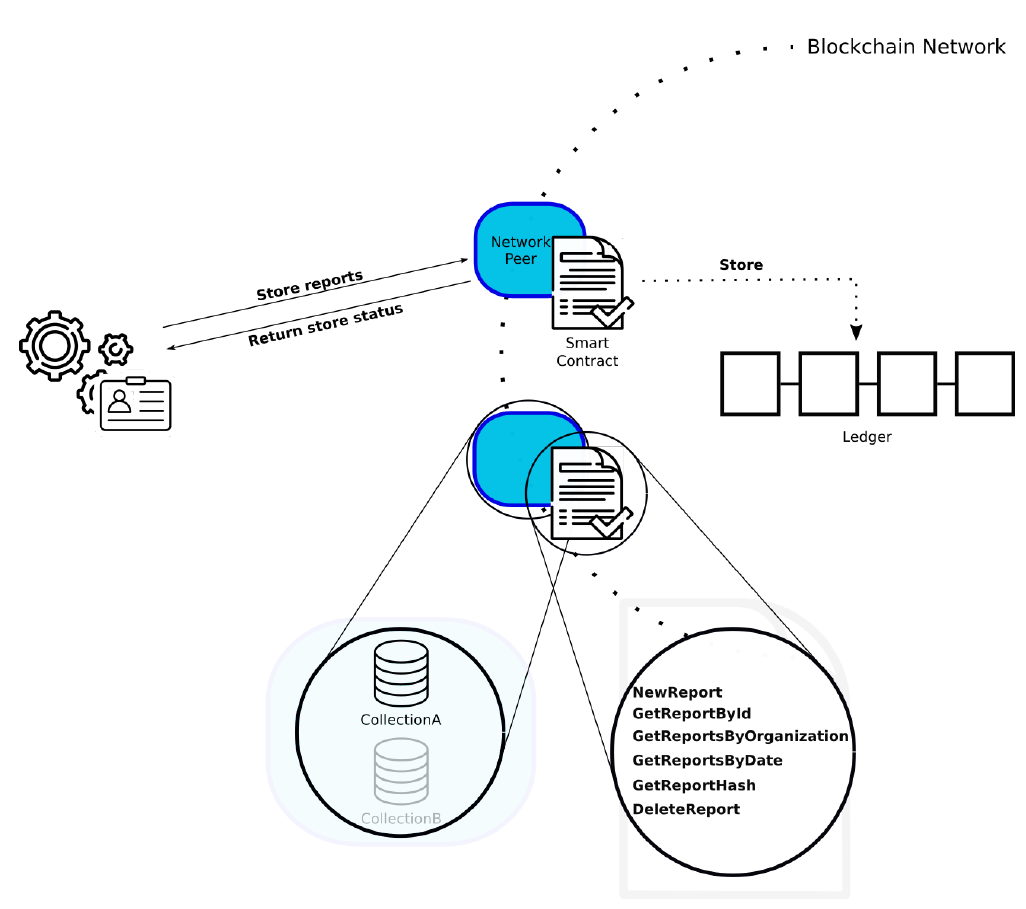
Figure 2. Hyperledger Fabric